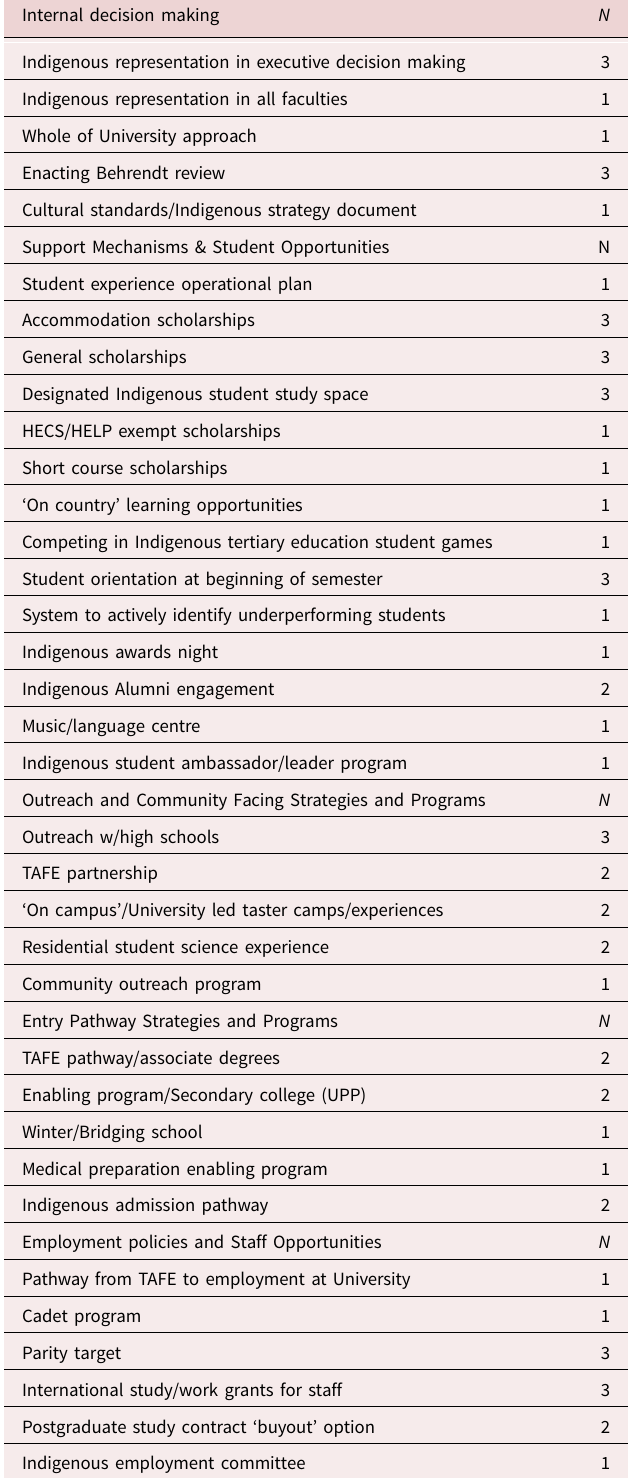
Table 5. Student support and opportunities, ‘ benchmark ’ universities 2009 –